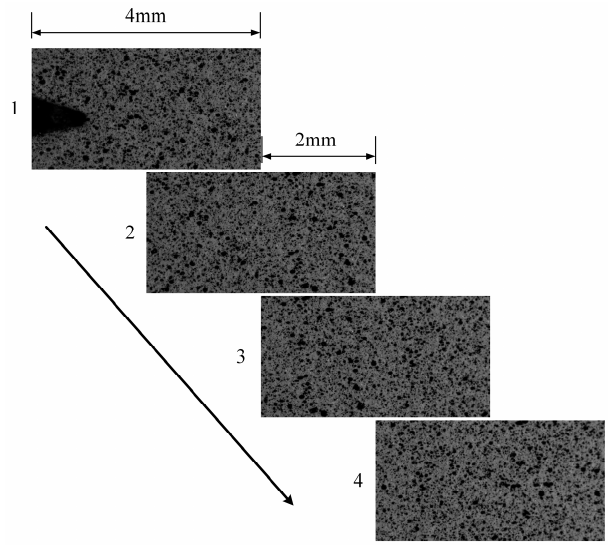
Figure 8. Sub-reference images.